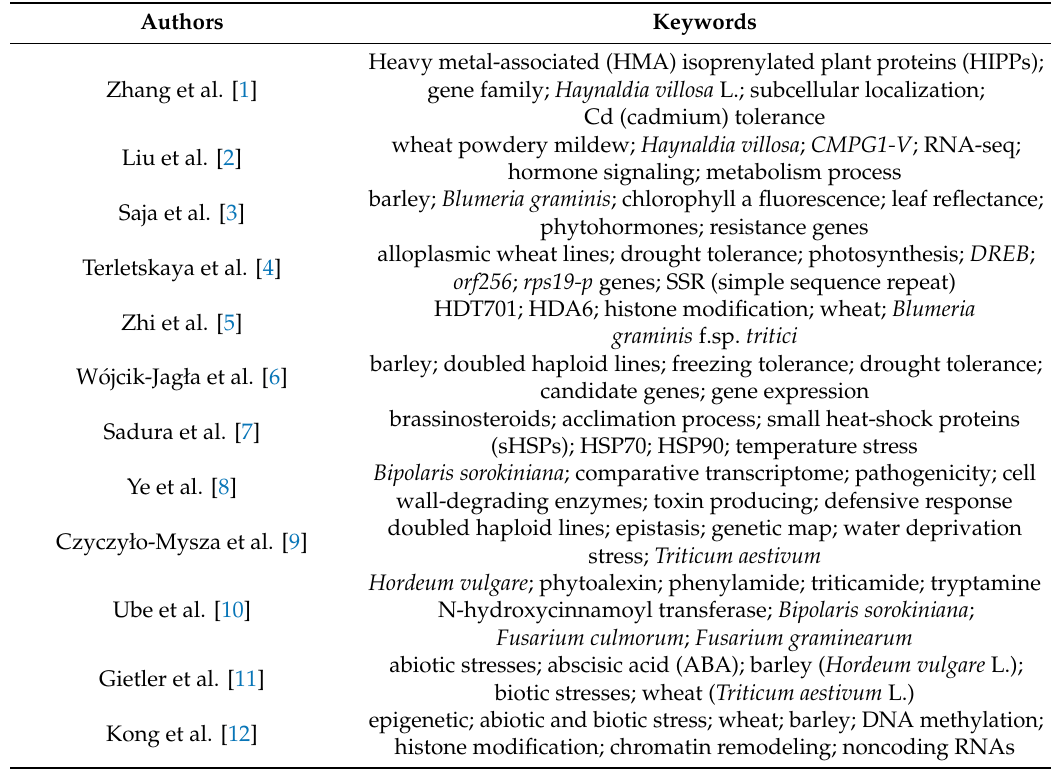
Table 1. Contributors to the Special Issue “Wheat and Barley: Acclimatization to Abiotic and Biotic